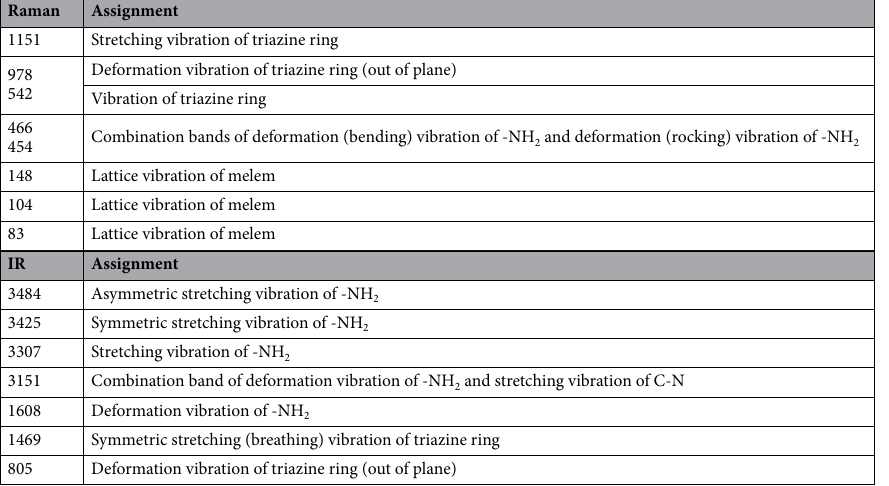
Table 3. The band assignment of spectra of both MM-g-CN-n% Ag sample series.